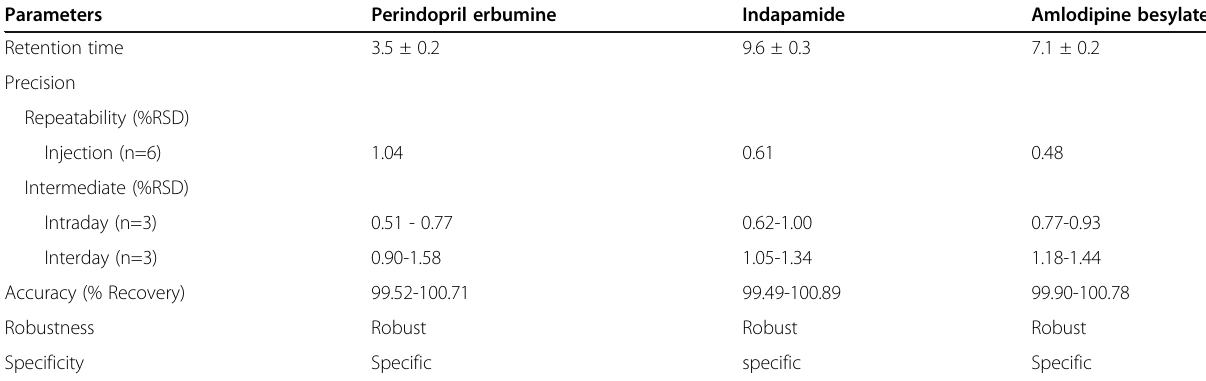
Table 4. Summary of validation parameter by proposed method